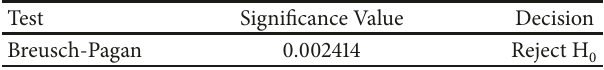
Table 2: Breusch-Pagan